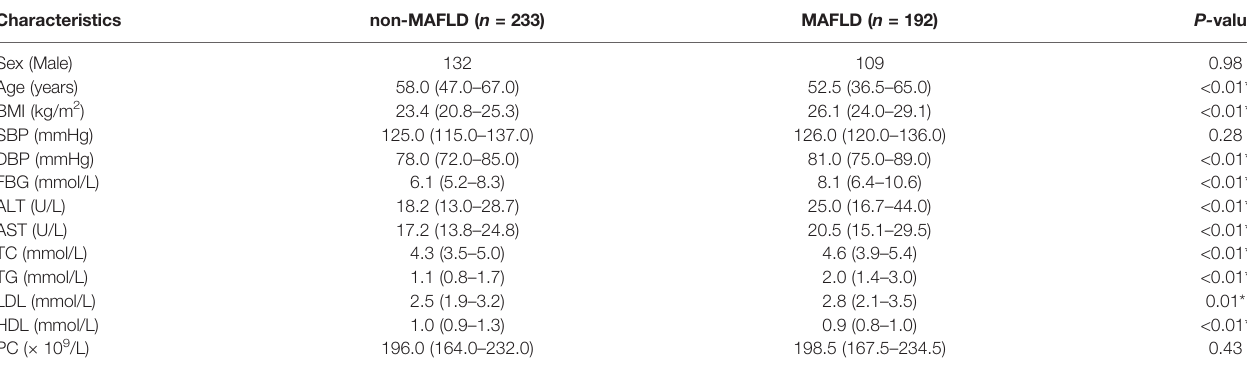
TABLE 1 | Baseline information of the non-metabolic dysfunction associated fatty liver disease (MAFLD) group and MAFLD group [median (interquartile range)].